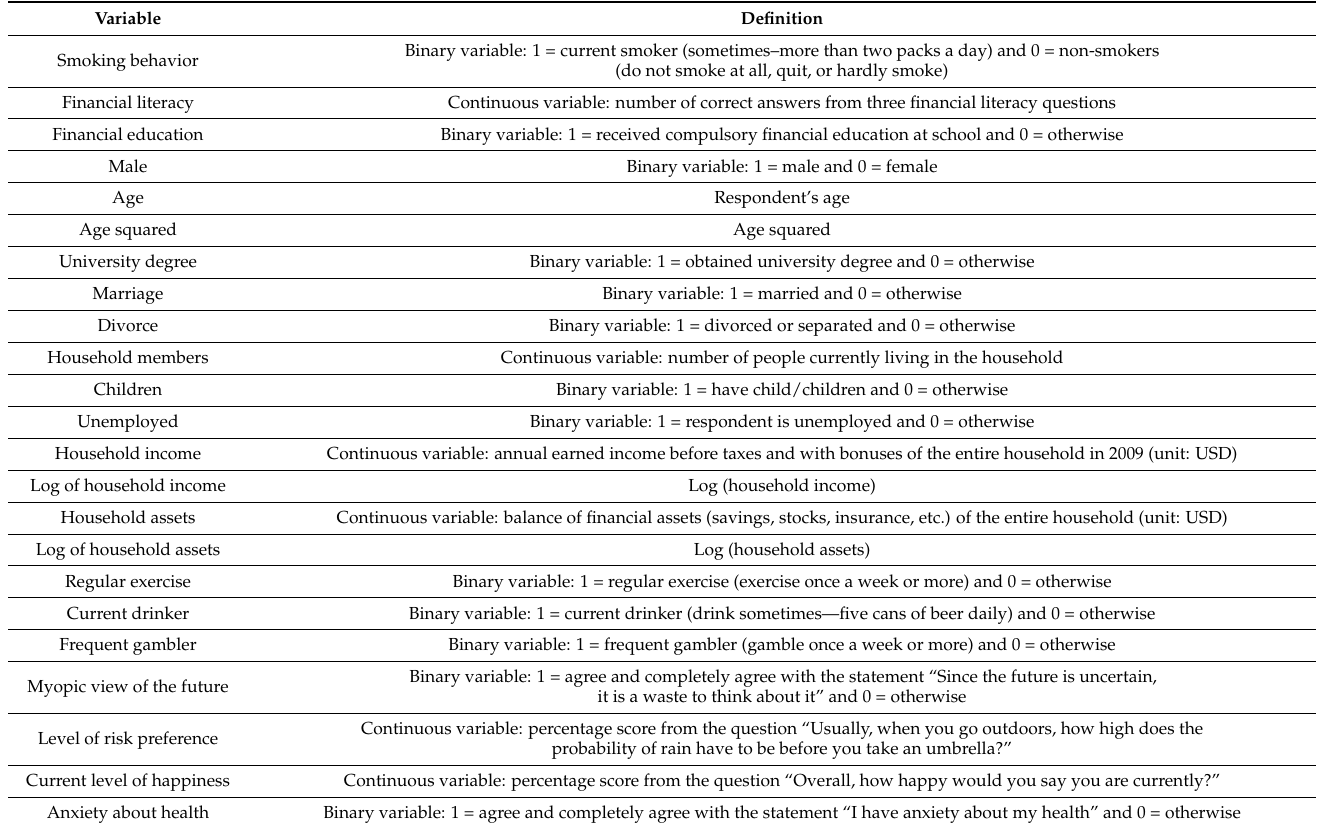
Table 1. Variable